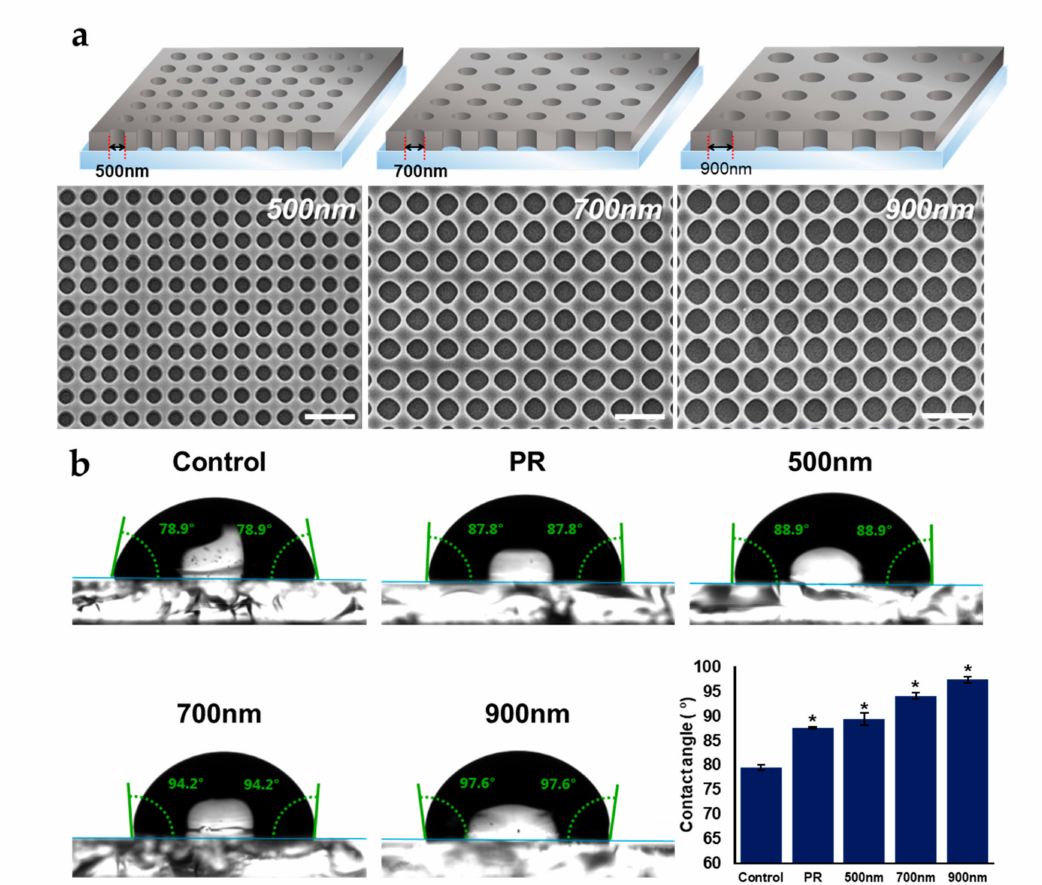
Figure 2. Surface characterization of substrates. ( a ) Field emission scanning electron microscopy (FE-SEM) images of homogeneous nanohole pattern arrays (HNPAs) with hole size of 500 nm, 700 nm, and 900 nm, ( b ) Contact angle measurements for all groups. Control = bare indium tin oxide (ITO) substrate; * Compared to control group, p < 0.05, n = 3; unpaired student (cid:48) s t -test, scale bar = 2 µ